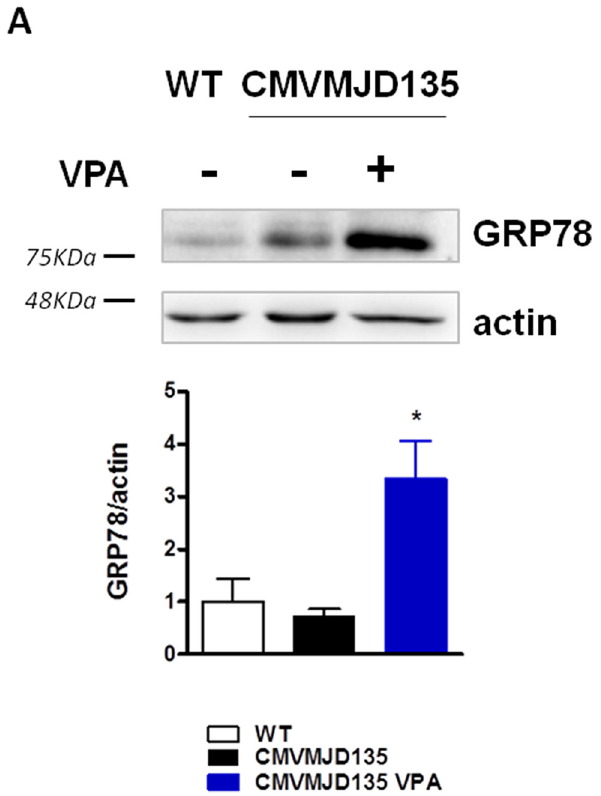
Fig 6. Cerebellum western-blot and quantification of GRP78 protein levels in 30 week-old WT, VPA- treated and non-treated CMVMJD135 mice. GRP78 protein induction in CMVMJD135 animals upon VPA treatment. Bars represent the mean ± SEM (n = 4 for each group), * represent p < 0.05, One-way ANOVA.